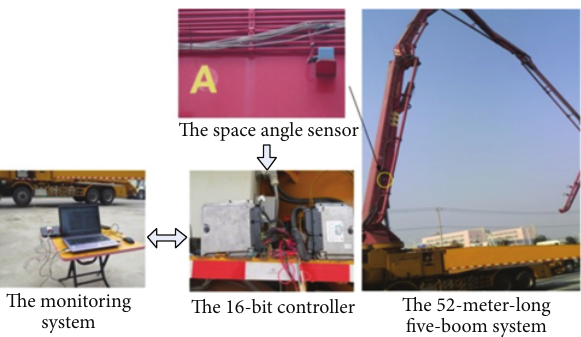
Figure 6: Double-direction dead-zone compensation.